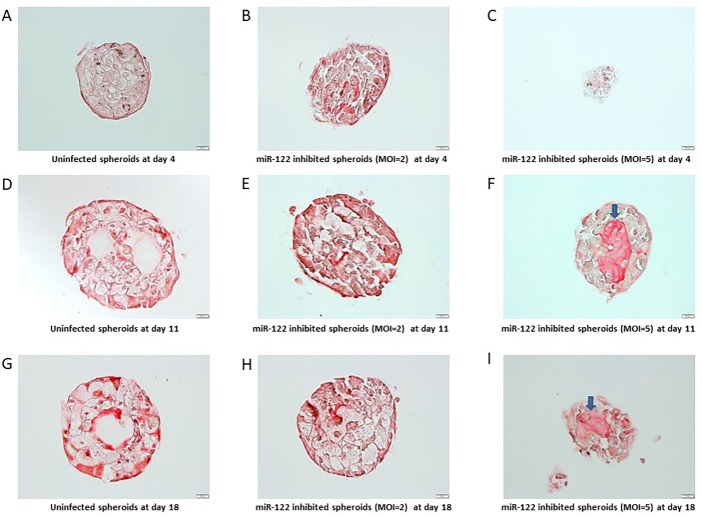
Sirius red staining of liver organoids.IHC sections of liver organoids stained with Sirius Red at 4 days post-infection (A-C), 11 days post-infection (D-F), and 18 days post-infection (G-I). Left column pictures (A, D, G) show control organoids, middle column show miR-122 inhibited organoids with MOI = 2 (B, E, H), right column show miR-122 inhibited organoids with MOI = 5 (C, F, I). Arrows indicate fibrosis.